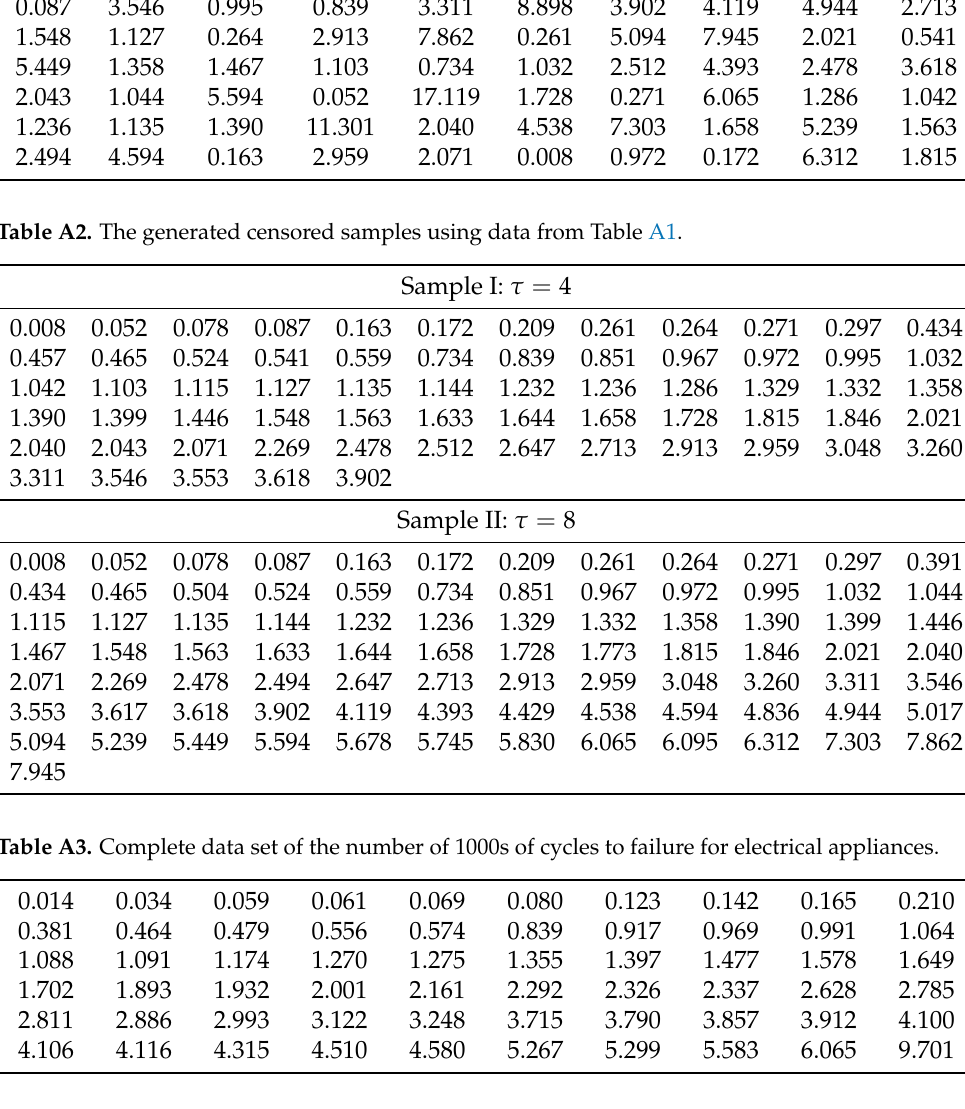
Table A4. The generated censored samples using data from Table A3. Sample I: τ =